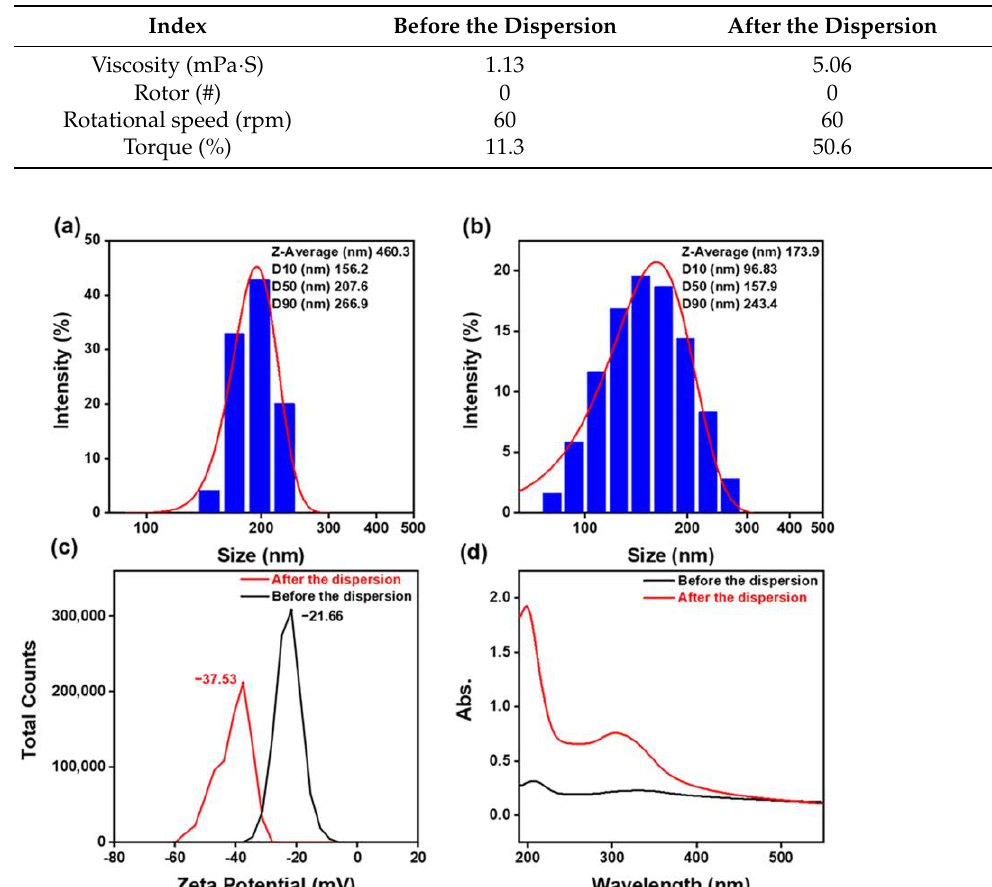
Figure 7. ( a , b ) Comparison of particle size of polishing slurry before and after dispersion; ( c ) comparison of zeta potential of polishing slurry before and after dispersion; ( d ) comparison of UV absorbance of polishing slurry before and after dispersion. Table 2. Comparison of the viscosity of the polishing slurry before and after dispersion.